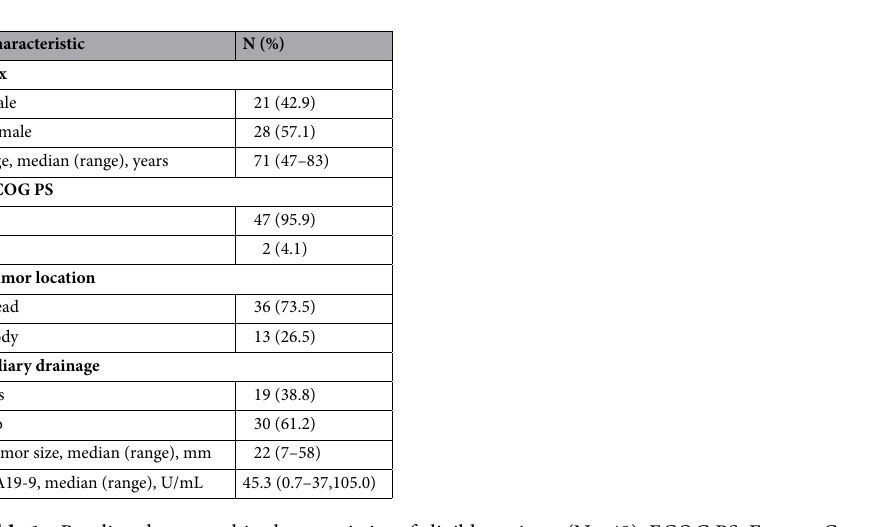
Table 1. Baseline demographic characteristics of eligible patients (N = 49). ECOG PS, Eastern Cooperative Oncology Group performance